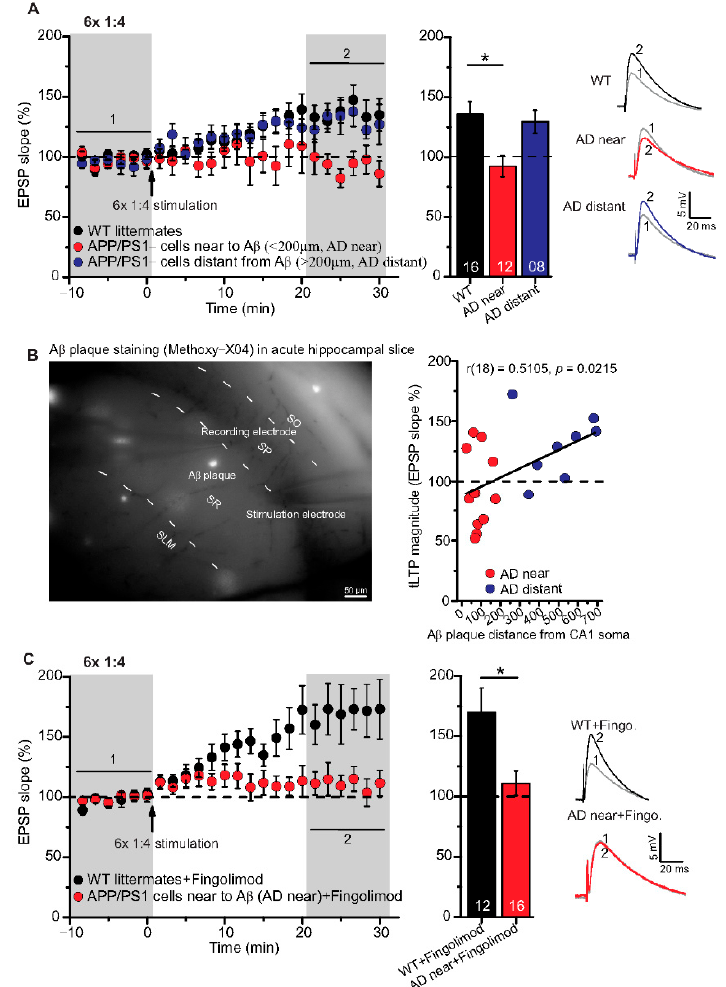
Figure 4. Impairment of t-LTP in adult APP/PS1 mice depends on proximity of recorded CA1 neuron to A β plaques. Whole cell patch clamp recording of t-LTP in acute hippocampal slices as described in Figure 2. Left: Mean time-course of EPSP slopes for 6× 1:4 paradigm (indicated by arrow). Right: Averaged change in EPSP slopes 21-30 min following t-LTP induction normalized to control before t-LTP induction. ( A ) APP/PS1 mice showed impaired t-LTP in CA1 neurons near to A β plaques (<200 µm, AD near, red circles, n = 12/N = 9; vs. WT: p = 0.009), while in CA1 neurons distant from A β plaques (>200 µm, AD distant, blue circles, n = 8/N = 4; vs WT: p = 0.92), t-LTP magnitude was comparable to WT littermate mice (black circles, n = 16/N = 9). ( B ) Methoxy-X04 staining of A β plaques in acute hippocampal slices. APP/PS1 mice showed moderate positive correlation between CA1 cell soma distance from A β plaque and t-LTP magnitude (Pearson correlation coefficient r(18) = 0.5105; p = 0.02). ( C ) No rescue of impaired t-LTP in APP/PS1 mouse CA1 neurons near to plaques after chronic fingolimod (FTY720) treatment (red circles, n = 16/N = 7; p = 0.01), compared to fingolimod treated WT littermates (black circles, n = 12/N = 7). Data are shown as mean ± SEM. Insets: average EPSP before (1) and after t-LTP induction (2). Digits in the bars indicate the number of recorded neurons per condition. *: p < 0.05, multiple comparisons were performed with ANOVA followed by post hoc Tukey’s test ( A ), while non-parametric data were compared with Mann–Whitney U-test ( C ). A β : amyloid-beta, SO: stratum (S) oriens, SP: S. pyramidale, SR: S. radiatum, SLM: S. lacunosum moleculare.